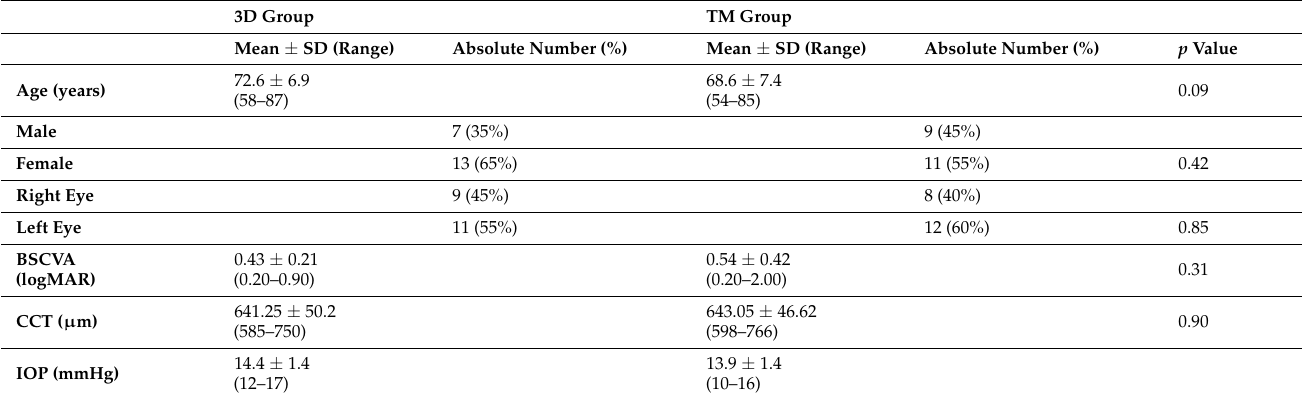
Table 1. Patient demographics and corresponding preoperative clinical